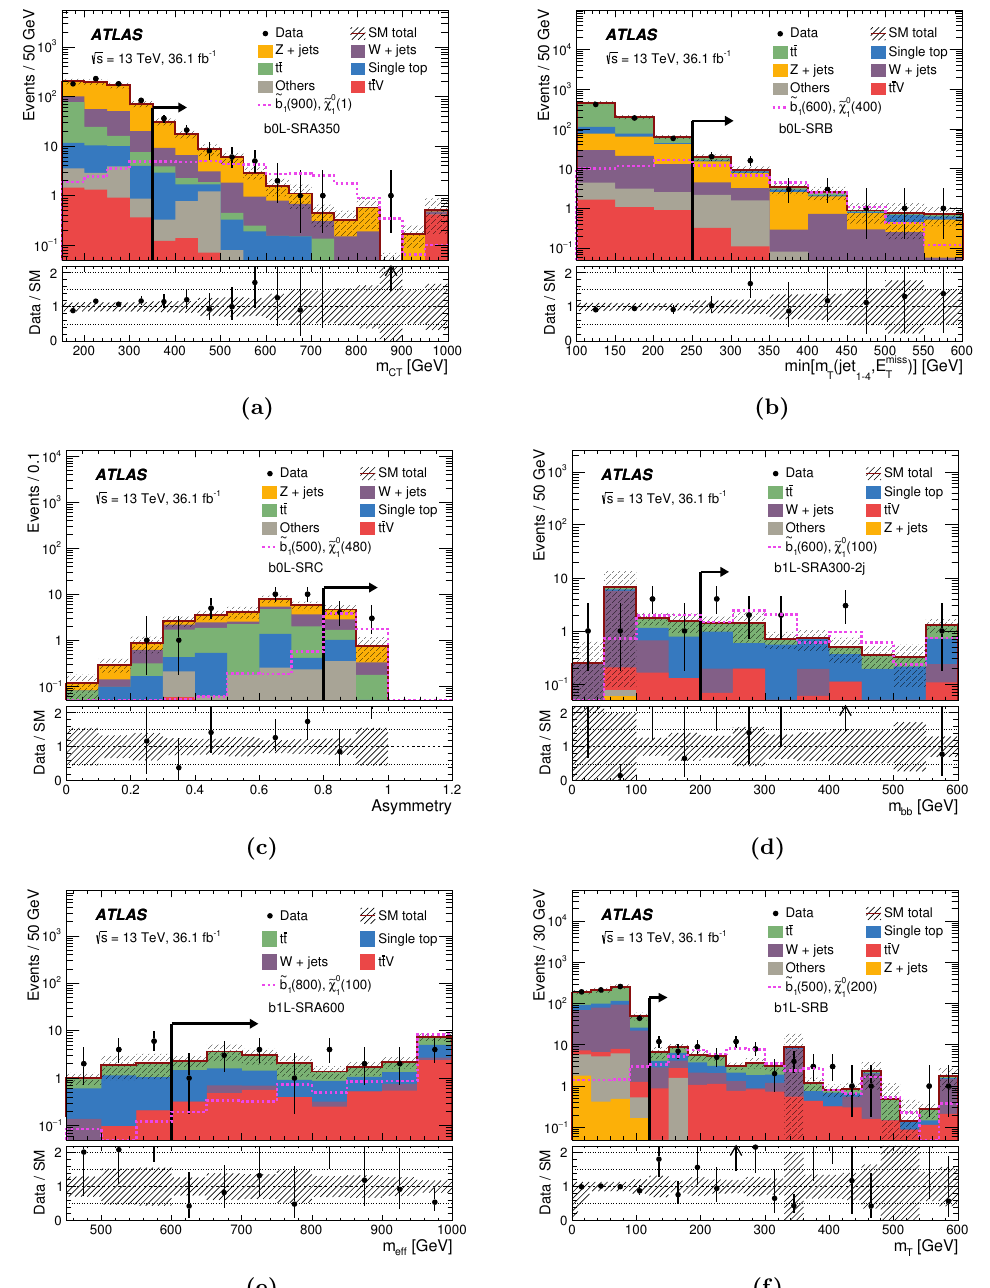
Figure 6. Distributions of (a) m CT in b0L-SRA, (b) min[ m T (jet b0L-SRC, (d) m bb in b1L-SRA300-2j, (e) m e(cid:11) in b1L-SRA, (f) m T in b1L-SRB. All selection criteria are applied, except the selection on the variable that is displayed in each of the plots. The arrows indicate the (cid:12)nal selection applied in the signal regions. The shaded-grey band shows the detector- related systematic uncertainties and the statistical uncertainties on the MC samples. The SM backgrounds are normalized to the values determined in the (cid:12)t. The contributions from diboson, multijet and rare backgrounds are collectively called \Others". For illustration the distribution expected from selected signal models are overlaid. The last bin includes over(cid:13)ow events.